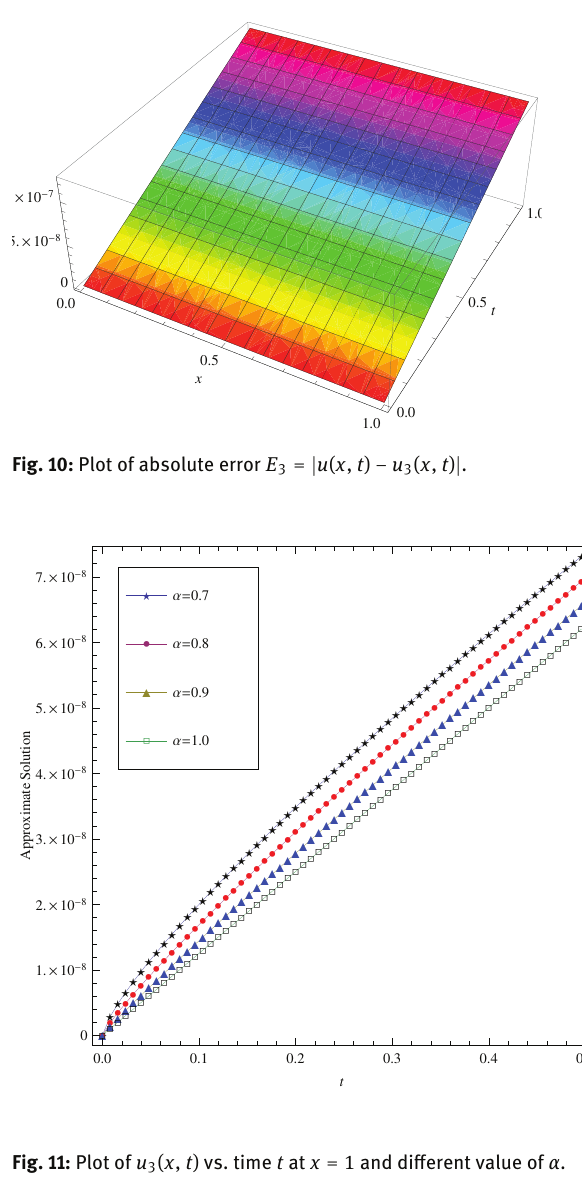
Fig. 11: Plot of u 3 ( x , t ) vs. time t at x = 1 and different value of α